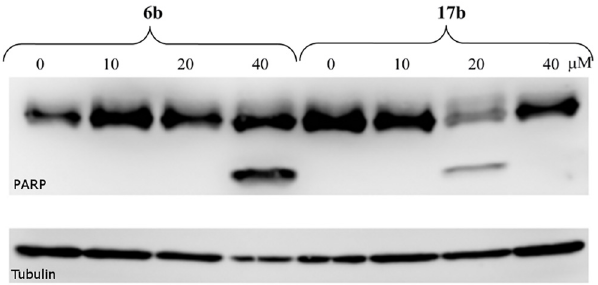
Fig 7. Tubulin level (a) and PARP cleavage (b) in HCT-116 cells for 6b (0, 10, 20, 40 μ M) and 17b (0, 10, 20, 40, μ